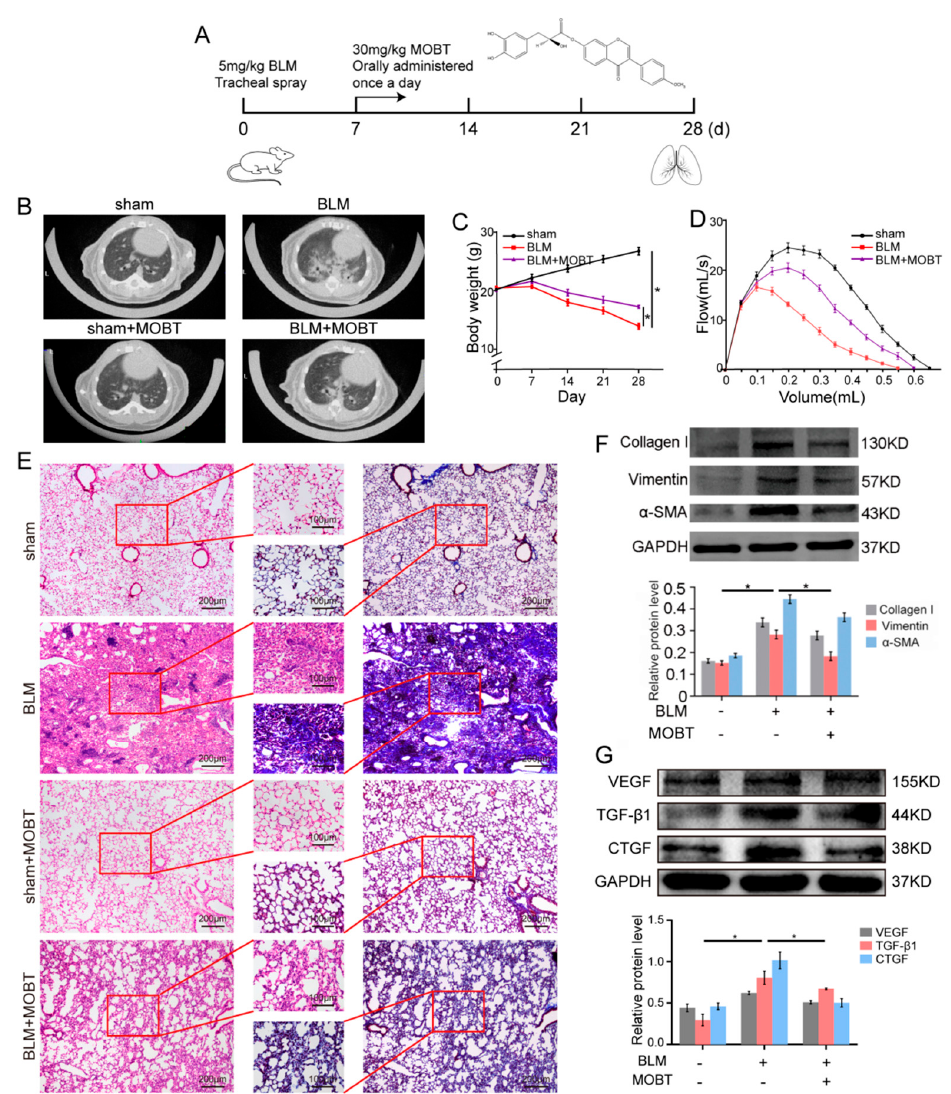
Figure 1. MOBT alleviated pulmonary fibrosis in vivo. ( A ) Molecular formula of MOBT and schematic illustration of MOBT administrated into mice. ( B ) The MicroCT imaging system for small animals displayed that the plain scan of the lung window in the sham group showed the texture of both lungs was clear, and no exudation or space occupying lesions were found in the lung parenchyma. The MOBT alone had no obvious changes compared with the sham group. However, both lower lungs of the mice in the BLM group showed diffused reticular blurring and interstitial changes. Meanwhile, the BLM + MOBT treatment group significantly reduced the lesion range of reticular changes. ( C ) The body weight monitoring revealed that mouse weight in the BLM group was significantly reduced compared with the sham group, whereas in the MOBT group it was increased compared with the BLM group. ( D ) The result of mice lung function showed that MOBT treatment improved the FVC. ( E ) H&E and Masson staining demonstrated that a portion of the alveolar structure was damaged, alveolar fusion, and collagen fibers were gathered in the lung of the BLM mice compared with the sham group, whereas MOBT alone group was similar to the sham. The BLM + MOBT treatment improved the alveolar structure and attenuated collagen deposition. ( F ) The Western blot demonstrated that MOBT inhibited the fibrotic protein expression, including collagen I, vimentin, and α -SMA compared with those in the BLM-treated group. ( G ) Western blot demonstrated that MOBT inhibited the expression of TGF- β 1, CTGF, and VEGF, which are cytokines related to fibrosis, compared with those in the BLM group. Each bar represents mean ± SD, n = 6, * p < 0.05.